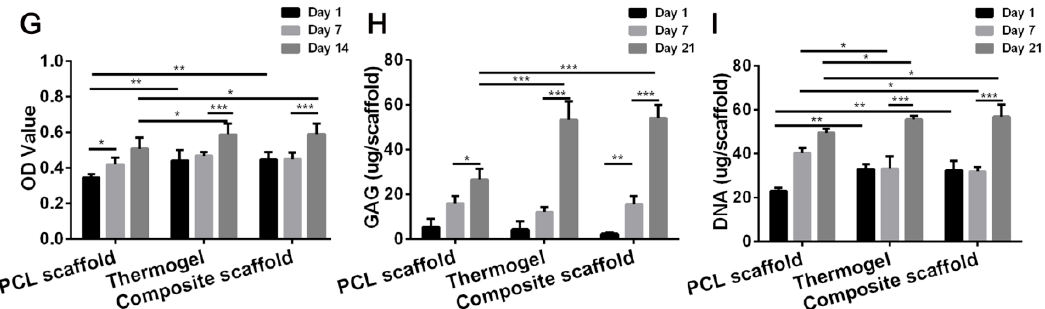
Figure 4. Representative images of attachment, viability, and distribution of BMMSCs in PCL scaffold ( A – C ) and composite scaffold ( D – F ). Bright field views show the contours of the PCL scaffold and composite ( A , D ). The dark area indicates the PCL fibers, and the bright area is the scaffold pores. CFLM images of LIVE/DEAD staining demonstrated in vitro cell viability and proliferation of three groups after culture for 72 h ( B , E ). The distribution of BMMSCs on the PCL scaffold and PCL/Gel composite scaffold were shown in the merged images ( C , F ). (Red, dead cells; green, live cells; scale bar = 250 μ m). CCK-8 assay and DNA content showed that the increased number of cells in the three groups over time ( G , H ). GAG deposition in various scaffolds by embedded BMMSCs ( I ). Results are expressed as mean ± SD ( n = 3; * p < 0.05, ** p < 0.01, *** p < 0.001).